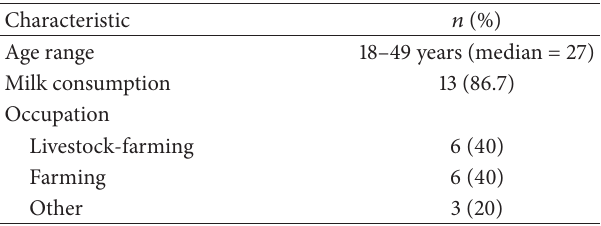
Table 2: Demographic characteristics of Brucella seropositive patients.